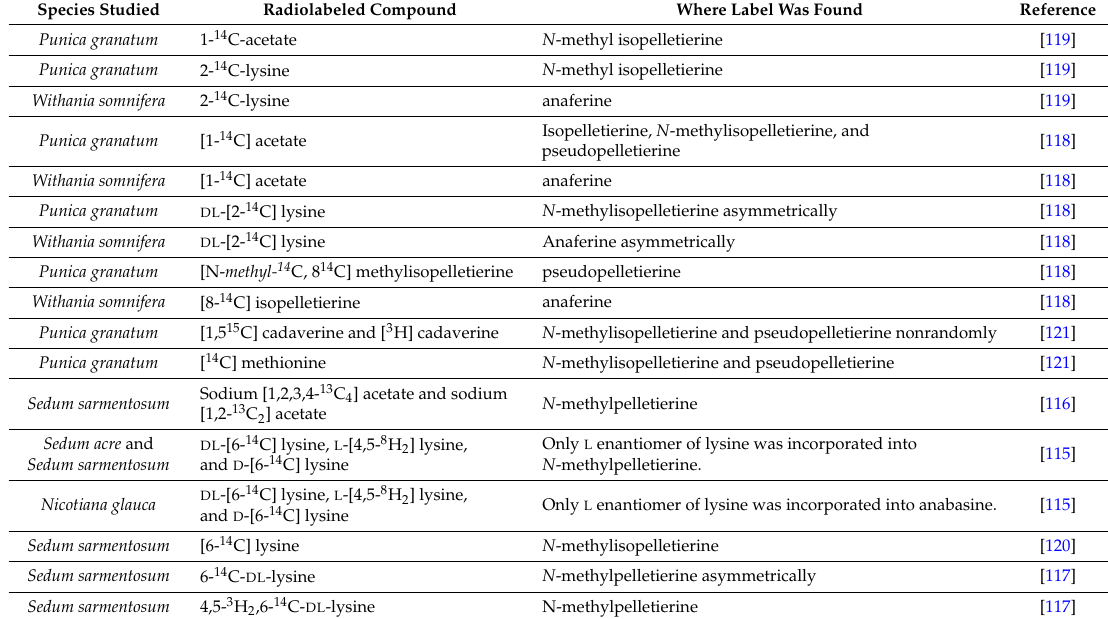
Table 1. Summary of radiolabel feeding studies performed on granatane-producing species. Species Studied Radiolabeled Compound Where Label Was